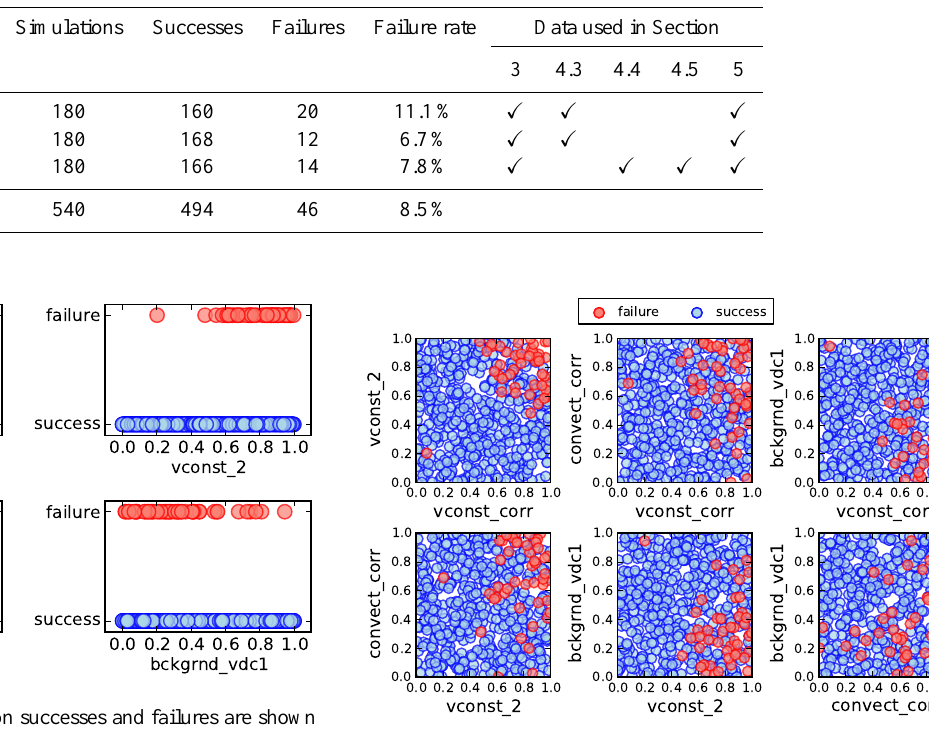
Fig. 2. Same as Fig. 1, but showing the two-dimensional projections for the same four model parameters.